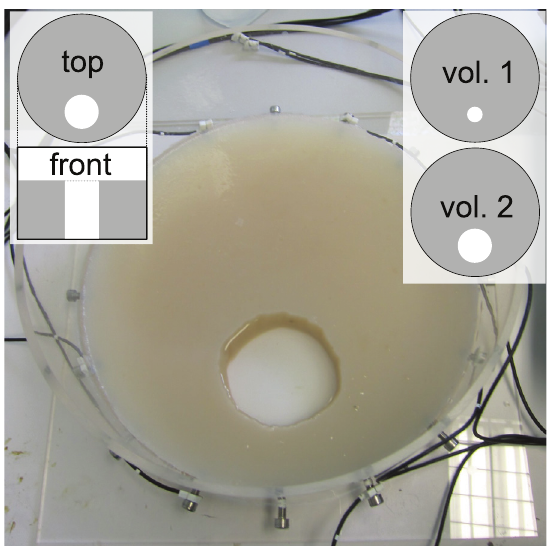
Fig.7: In-vitro tank filled with agar as a multi-frequency EIT phantom: A cylindrical cavity is cut into the agar and filled with solutions of different conductivities to model varying urine conductivity. The sketches visualize the spatial arrangement (left) and variation in cavity size (right).